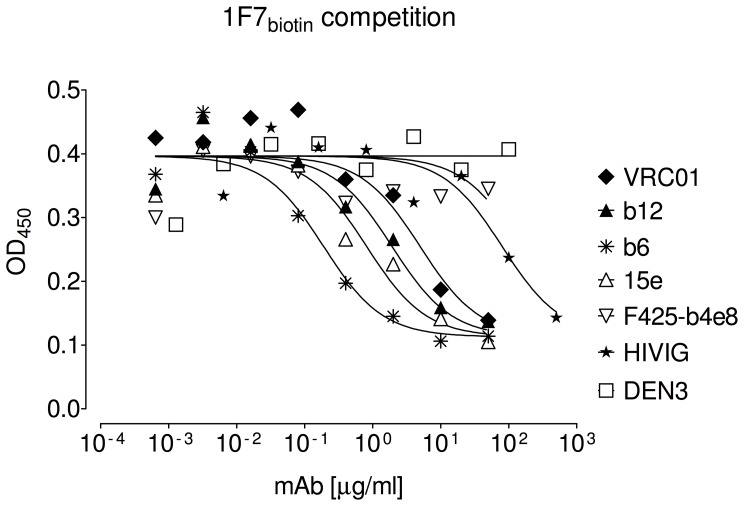
MAbs and HIVIG competition with 1F7 binding to gp120.MAbs b6, 15e, b12, HIVIG, F425-b4e8, VRC03, and VRC01 were co-incubated with a constant concentration of biotinylated mAb 1F7 and allowed to bind to immobilized gp120JR-FL. Curves were analyzed with GraphPad Prism 5.04 using a three-parameter fit with shared values for maximum and minimum binding. Data are representative of at least 3 titrations of each MAb against biotinylated mAb 1F7.